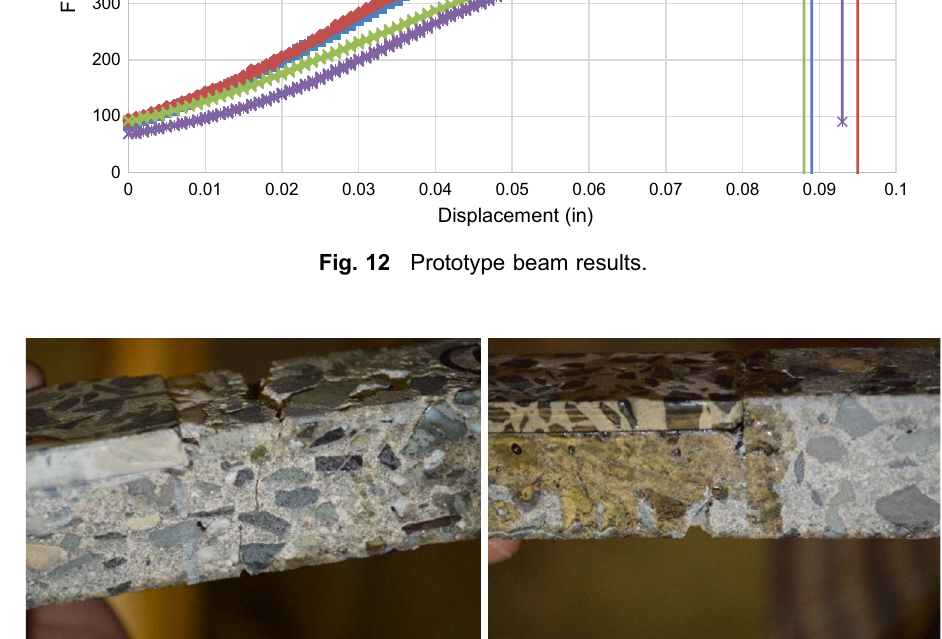
Fig. 13 Prototype failures; inorganic ( left ), organic ( right